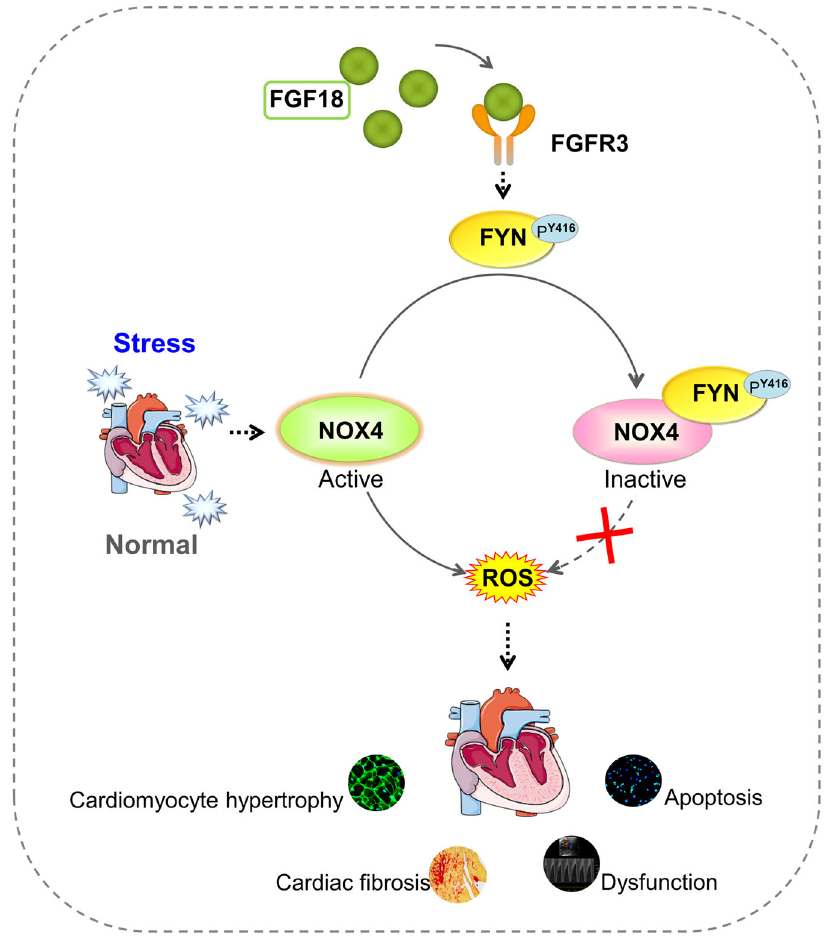
Fig.9|Schematic fi gureillustratesthatFGF18amelioratespathologicalcardiac hypertrophy and dysfunction by maintaining redox homeostasis by FYN/ NOX4 signal axis. FGF18/FGFR3 promoted the activity and expression of FYN and negatively regulated NOX4 activity, thereby inhibiting ROS generation and pro- tectingheartfunctionbyinhibitingcardiac fi